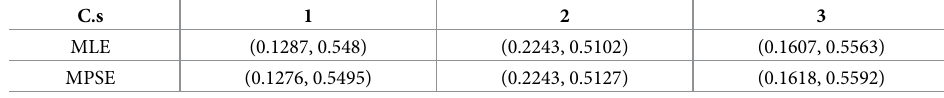
Table 20. Bootstrap confidence intervals for each estimate of θ for example 2.